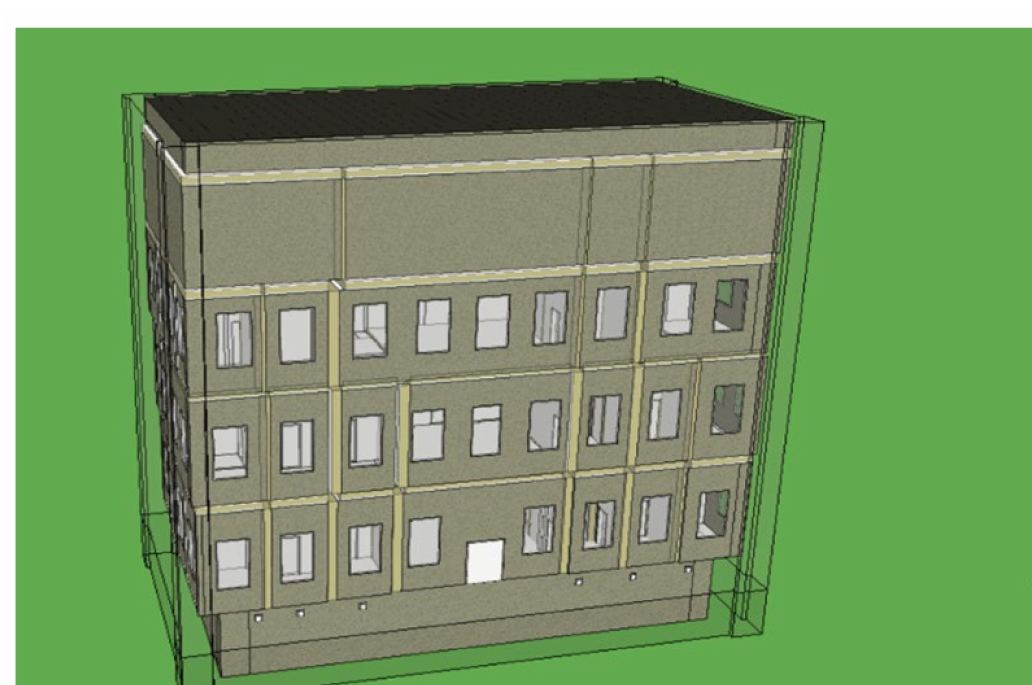
Figure 5. The 3D model of the building in IDA